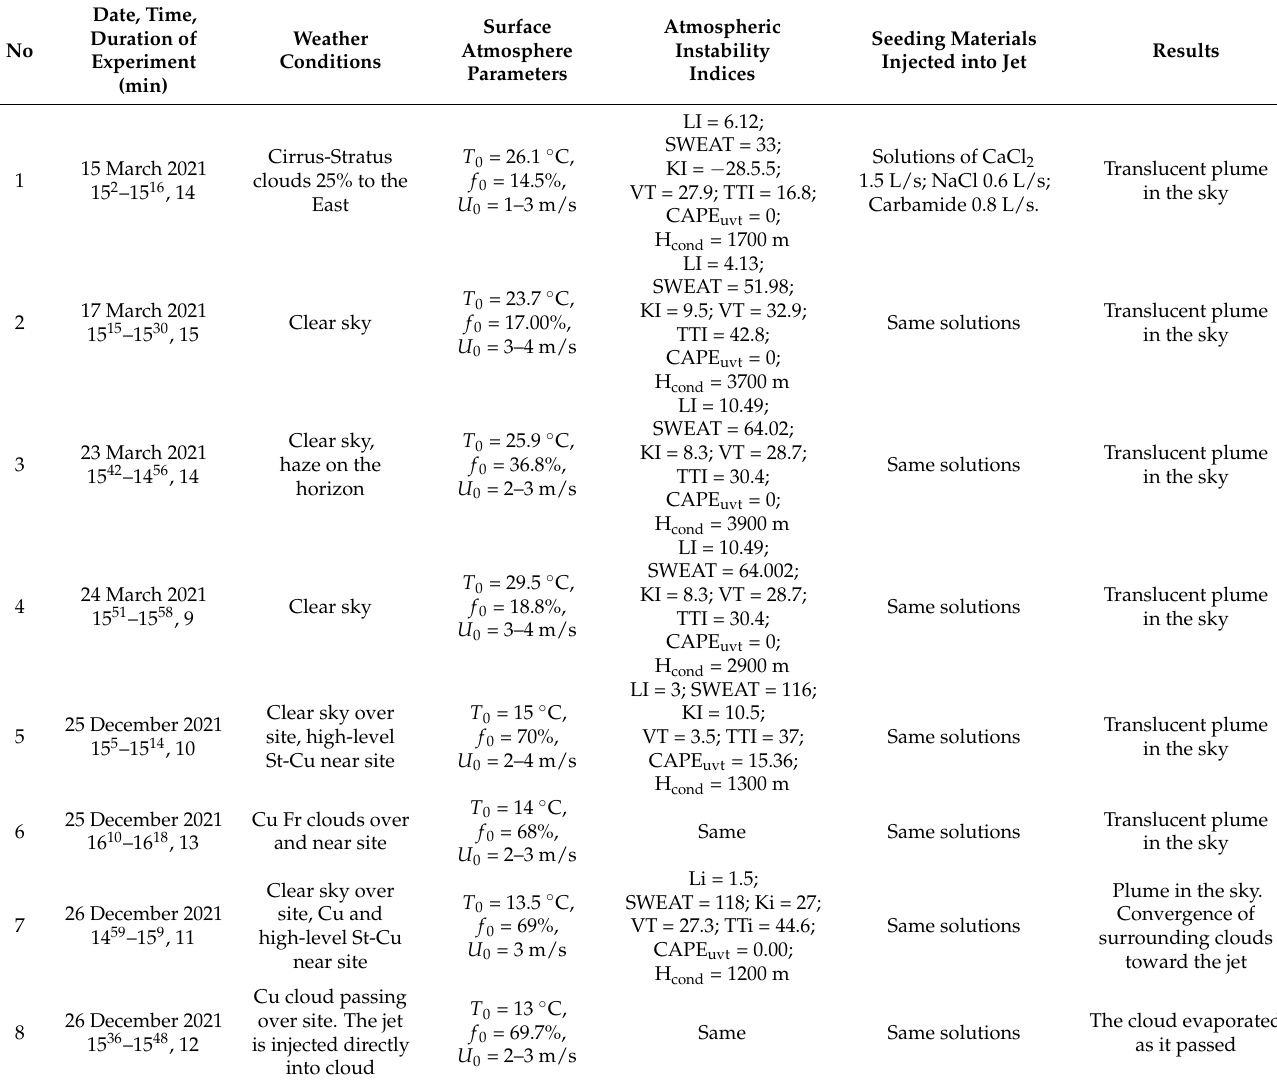
Table 3. Date, time, atmospheric conditions, and results of field experiments on the creation of artificial updrafts and